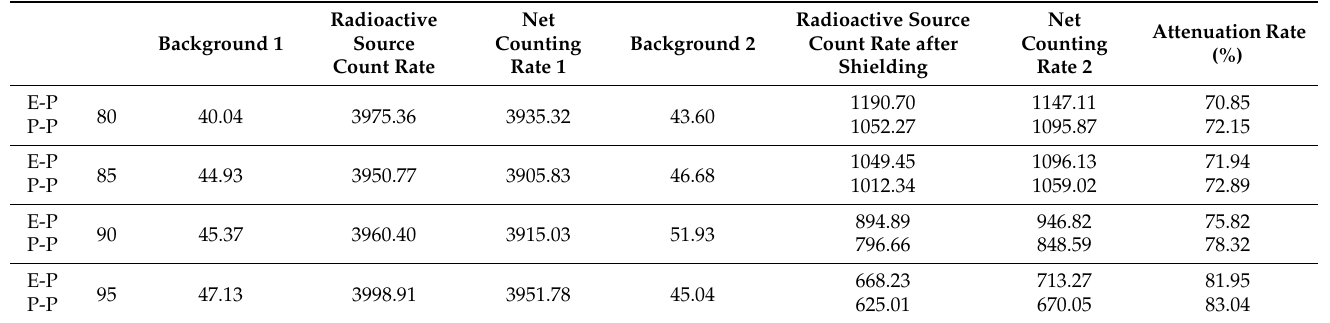
Table 2. Shielding performance evaluation of manufactured shielding